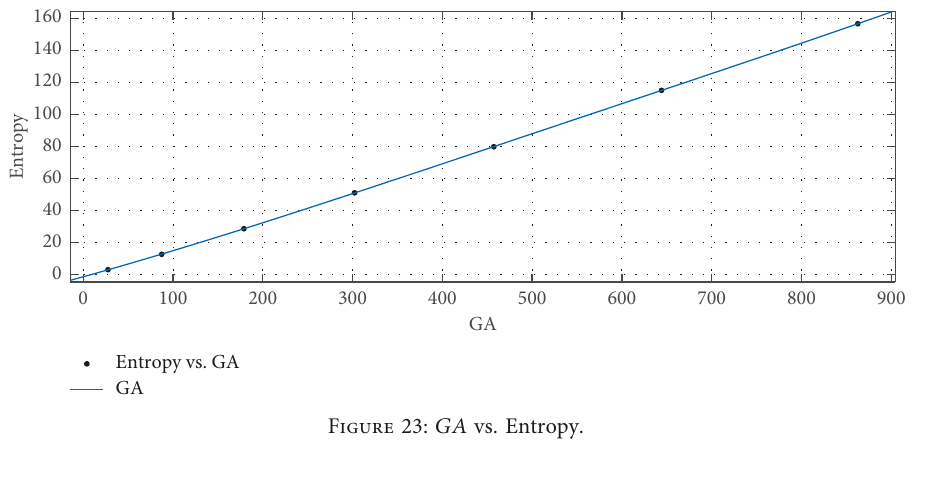
Figure 22: ABC vs. Entropy.